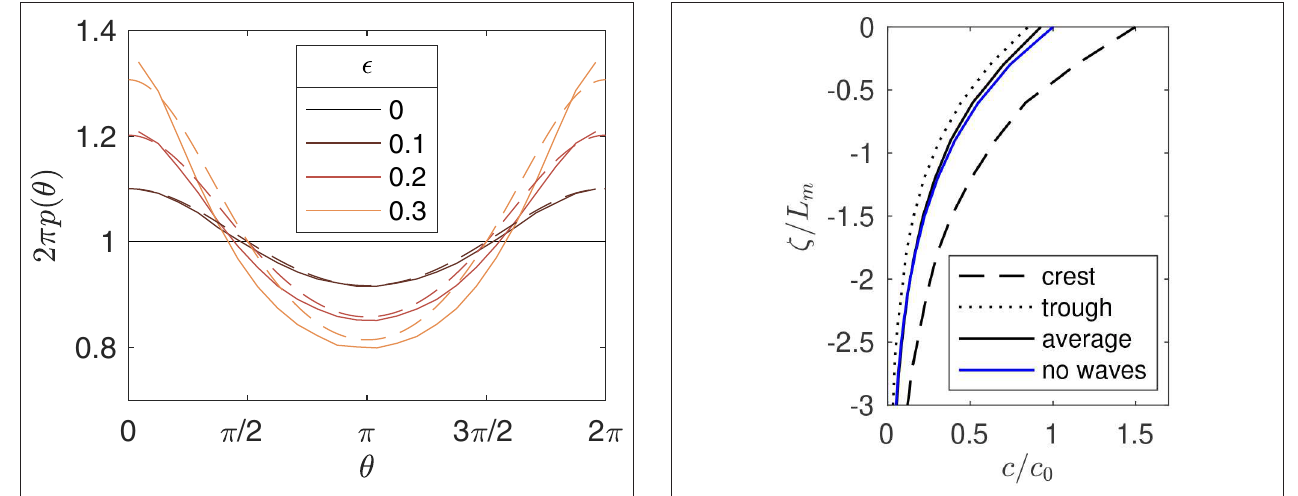
FIGURE 5 | Vertical distribution of relative concentration of buoyant particles 1 and ǫ is varied under waves as a function of wave phase from numerical simulations. Data = comes from a simulation with A / L m 3 and ǫ 0.2. The wave phase was = = subdivided where the crest is the region defined by θ < 0.04 π or θ > 2 π 0.04 π and the trough is defined by π 0.04 π < θ < π 0.04 π . − − + The no waves line shows the distribution from Equation (2), and the average line shows the wave-period averaged distribution.